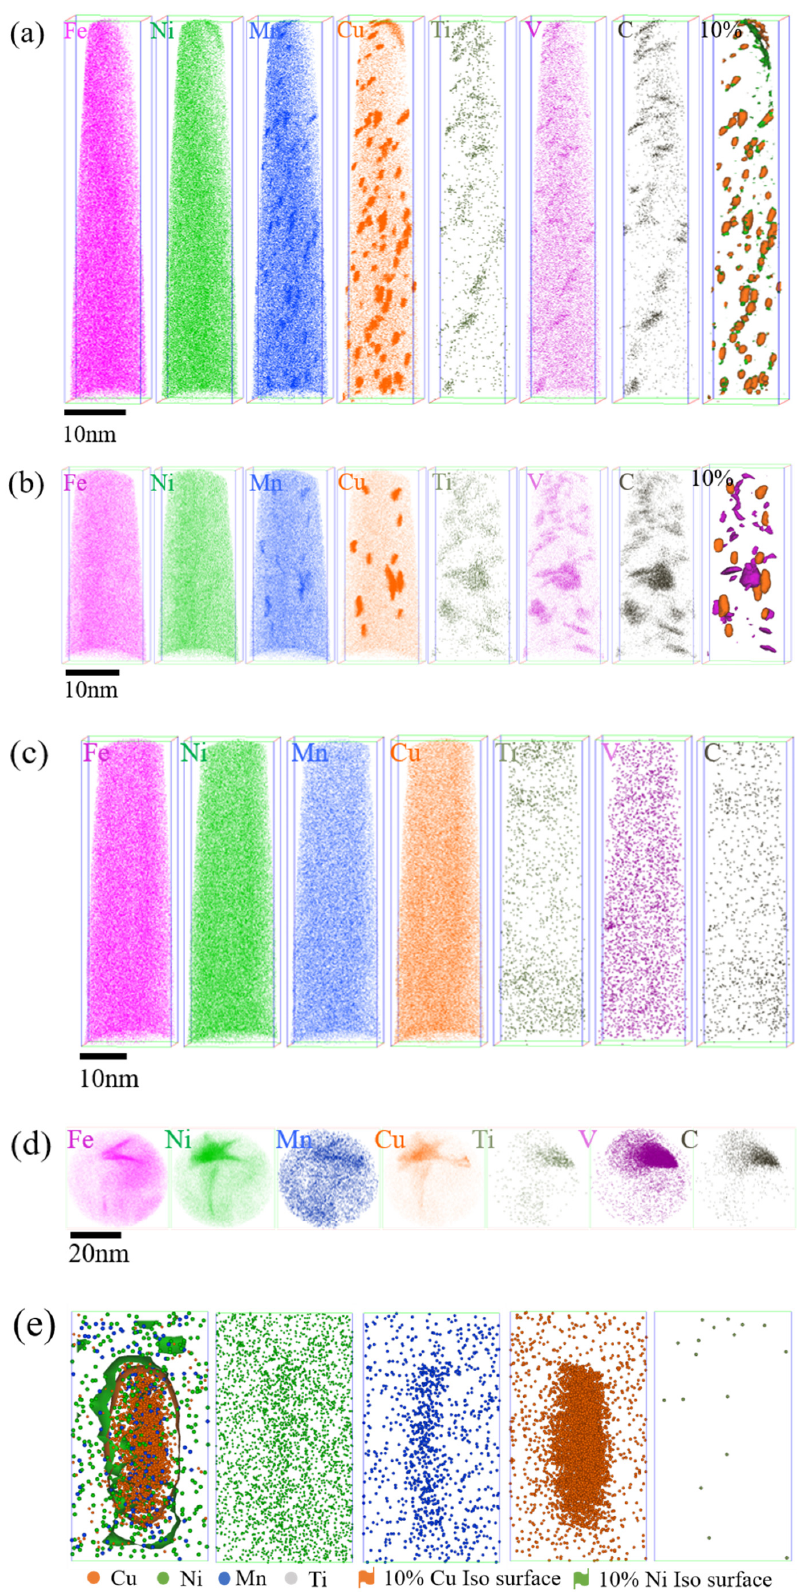
Figure 11. Spatial distribution of elements in Fe-9Ni-2Cu steels after tempering at different temper- tures. ( a ) 460 ◦ C; ( b ) 560 ◦ C; ( c ) 610 ◦ C; ( d ) z-610 ◦ C; ( e ) 10% Cu + Ni + Mn Iso surface after tempering atures. ( a ) 460 °C; ( b ) 560 °C; ( c ) 610 °C; ( d ) z-610 °C; ( e ) 10% Cu + Ni + Mn Iso surface after tempering at 560 ◦ at 560 °C.